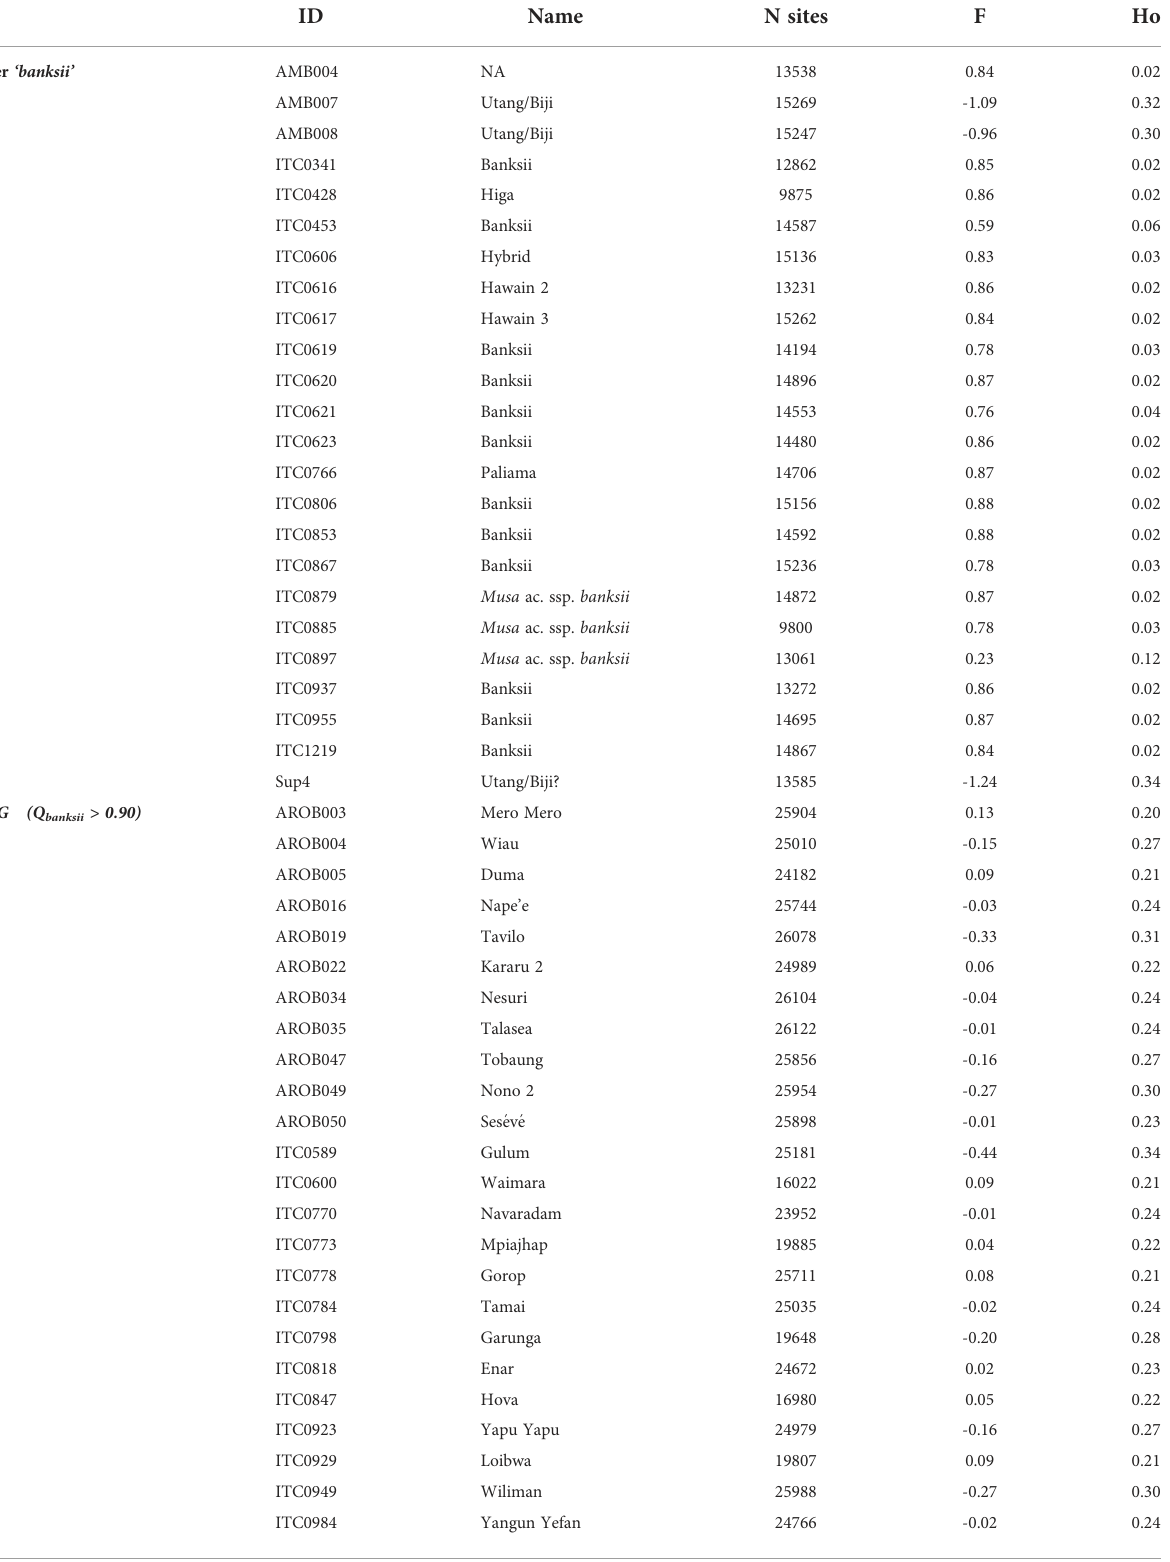
TABLE 2 Observed heterozygosity (Ho) and inbreeding coef fi cient (F) for the accessions of the clusters ‘ banksii ’ and ‘ AA NG ’